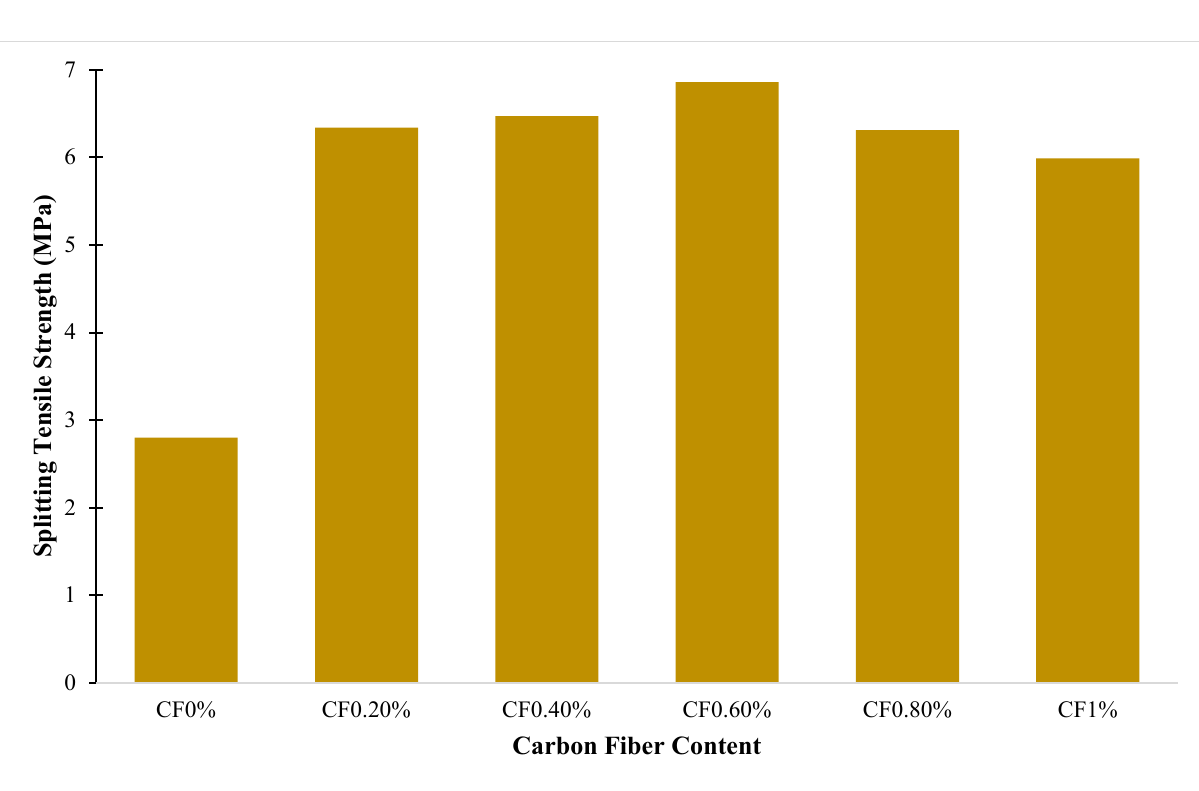
Figure 8. Relationship between concrete’s split tensile and compressive strengths.